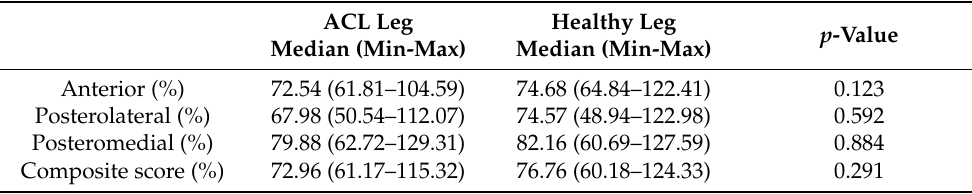
Table 3. YBT reach distances of the operated (ACL-Leg) and healthy leg (ANT, PL, and PM).